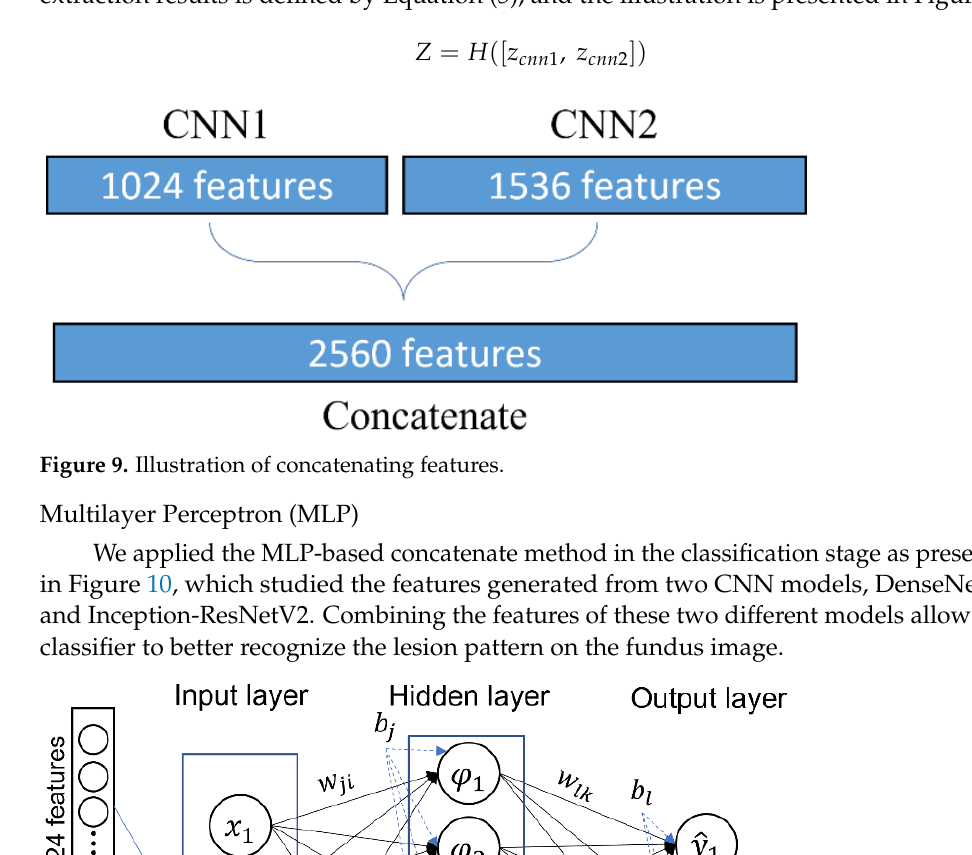
8 of 17 Figure 8. Inception-ResNetV2 architecture [30] . 2.4. Classification